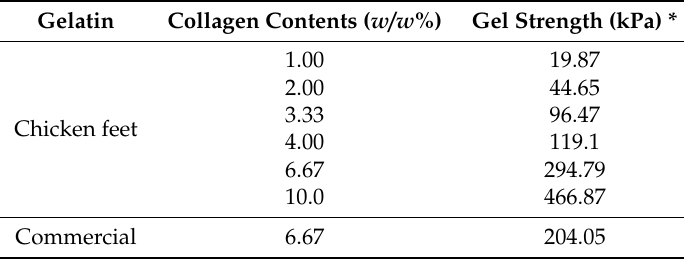
Table 7. Gel strength analysis of collagen from chicken feet.